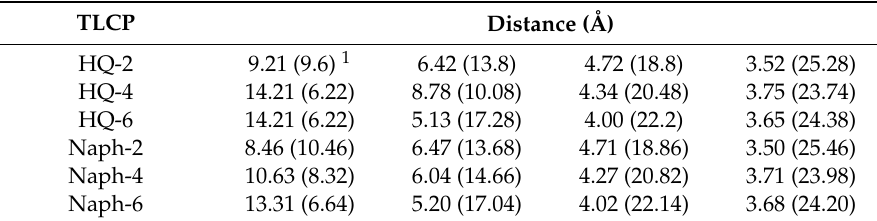
Table 2. d values corresponding to the XRD peaks of HQ‐ and Naph‐TLCPs.